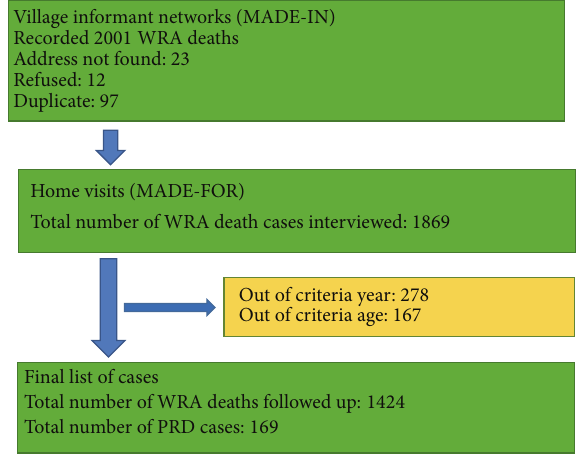
Figure 2: Flow of data